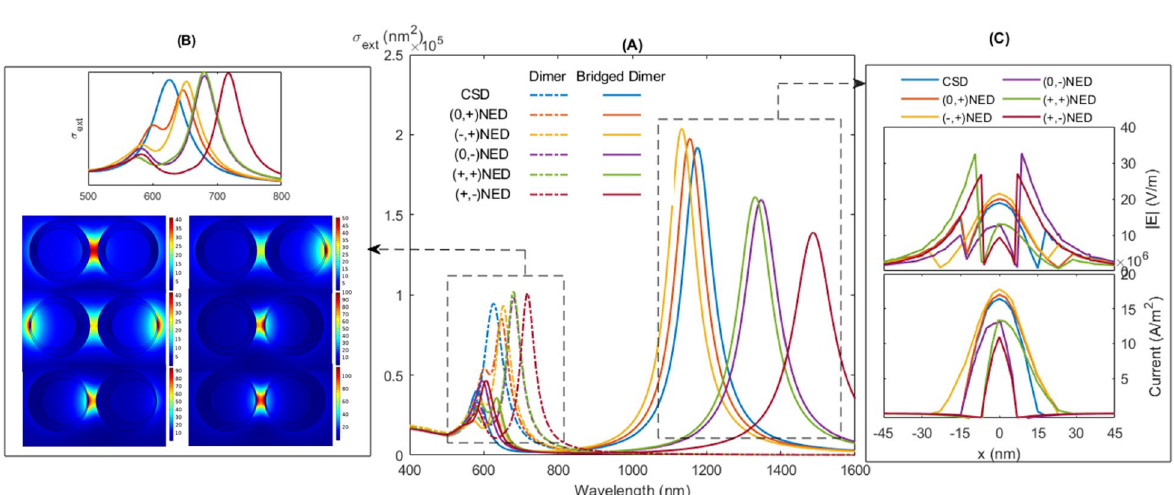
Figure 7. ( A ) Extinction spectra of dimers and bridged dimers composed of nanoeggs with different offsets, ( B ) E-field maps of different dimers calculated at the resonance wavelength, and ( C ) The variations of (UP) |E| and (Bottom) current along the monitoring lines across the gap areas for the bridged nanodimers at